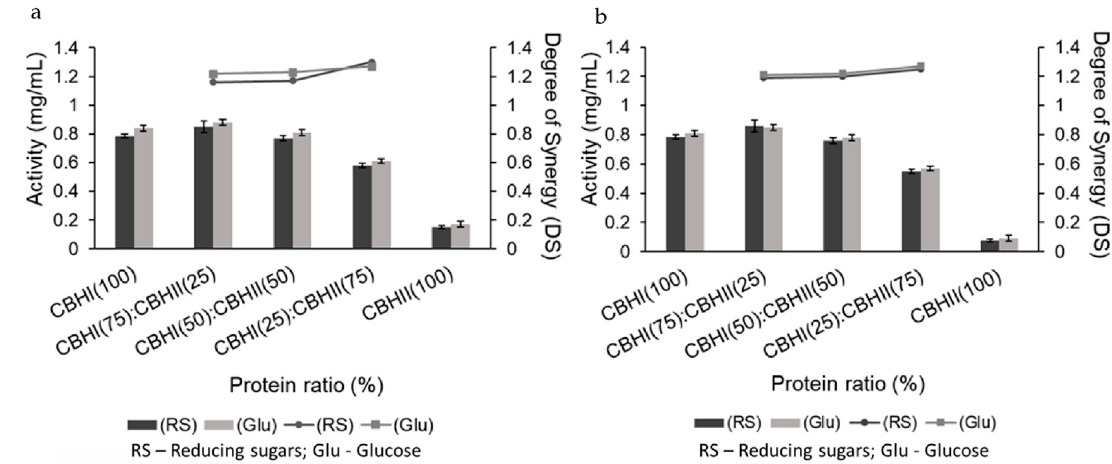
Figure 1. Synergistic degradation of Avicel by various ratios of Tl Cel7A (CBHI) and microbial Cel6A (CBHII) ( a ) and Tl Cel7A (CBHI) and Ct Cel5A (CBHII) ( b ). Assays were performed in sodium citrate buffer (0.05 M; pH 5.0) and incubated at 37 ◦ C for 24 h. Values represented as mean values ± S.D. ( n =